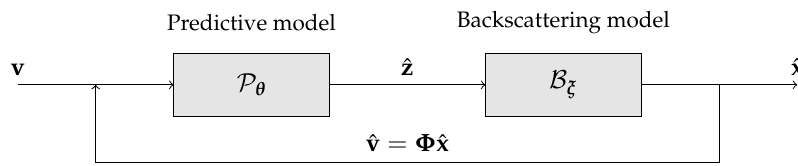
Figure 2. Structure of the proposed